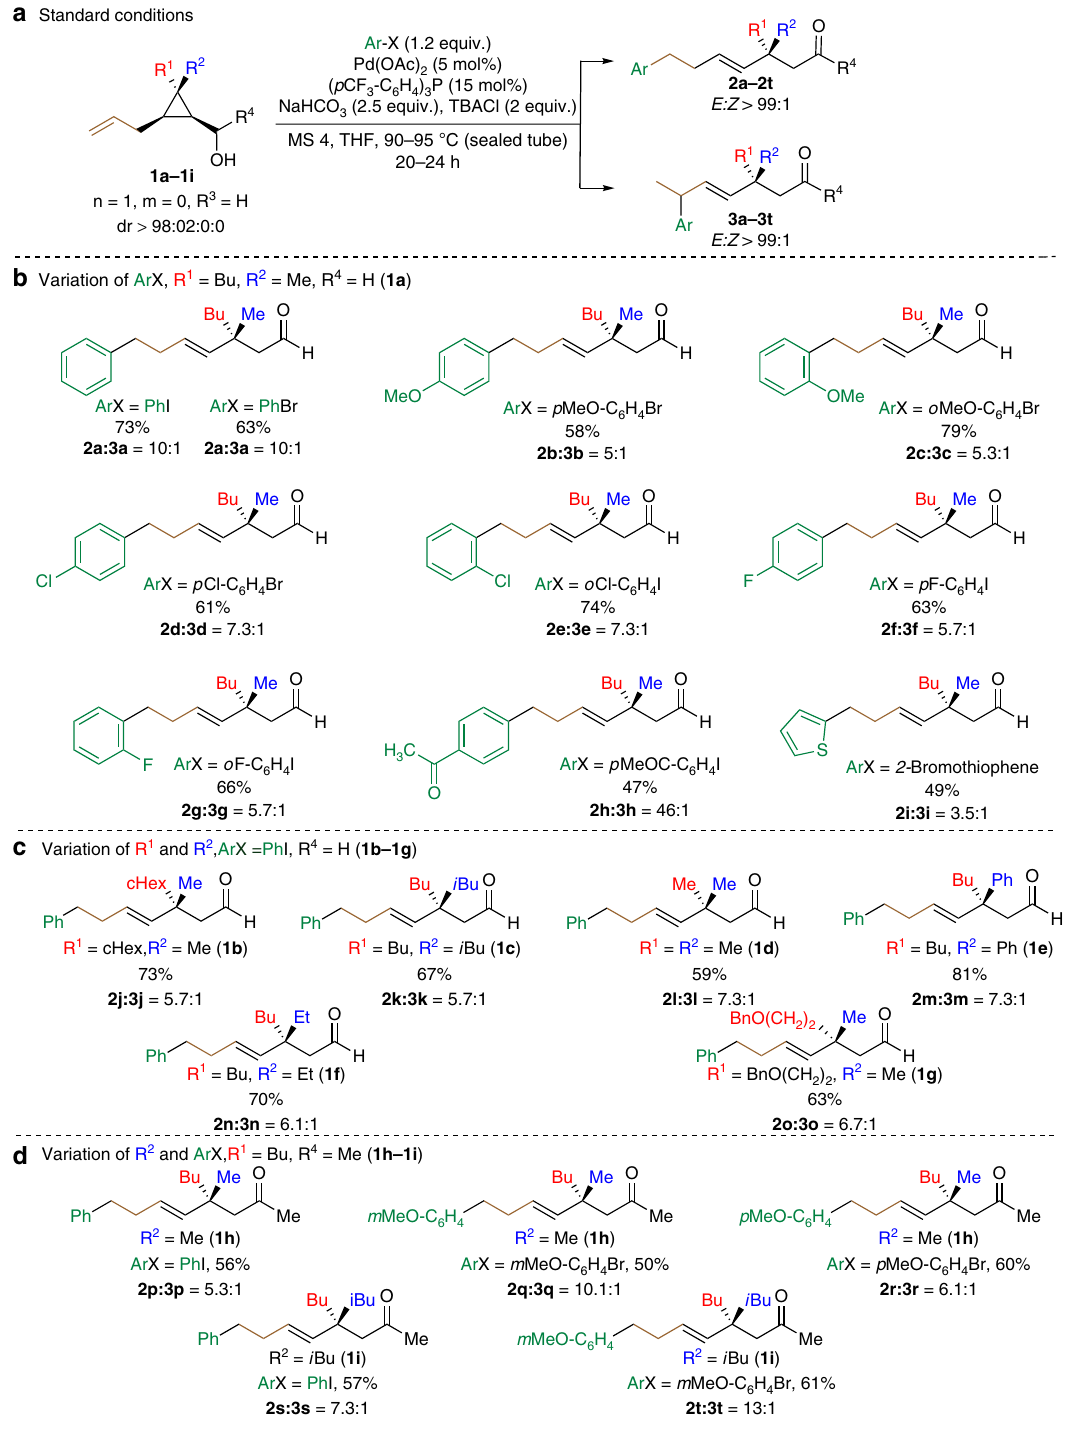
Figure 3 | Scope of the reaction by varying ArX, R 1 , R 2 and R 4 . ( a ) Standard experiment conditions for the coupling of 1 with ArX yielding 2 and 3 using a Pd(0)-based catalytic system. ( b ) Scope of the aryl halide (ArX). ( c ) Scope of the substitution pattern on the cyclopropyl carbinol moiety (R 1 and R 2 ). ( d ) Examples involving the transformation of secondary alcohol derivatives (R 4 ¼ Me) into ketones. Regioisomeric and E/Z ratios were determined by NMR and GC analyses of the crude reaction mixture. All represented yields are the combined yields of both regioisomers after purification by column